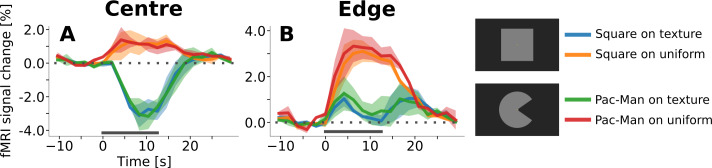
Event-related time courses from control experiment with texture background and uniform background, separately for regions of interest corresponding to the retinotopic representation of the centre of the stimulus (A) and to its edges (B).Irrespective of the shape of the stimulus (square or ‘Pac-Man’), there is a positive response to the centre of the stimulus when the background is uniform (A, red and orange lines), and a negative response when the stimuli are presented on a random texture pattern (A, green and blue lines). Interestingly, the positive response has a shorter latency than the negative response. The response to the edges of the stimuli is positive under all conditions (B). However, the response amplitude is much stronger when the stimuli are presented on a uniform background. Moreover, the temporal dynamics changes as a function of the background; the response is sustained when the background is uniform (B, orange and red lines), but transient for the texture background (B, green and blue lines). The horizontal grey bar marks the duration of the stimulus.